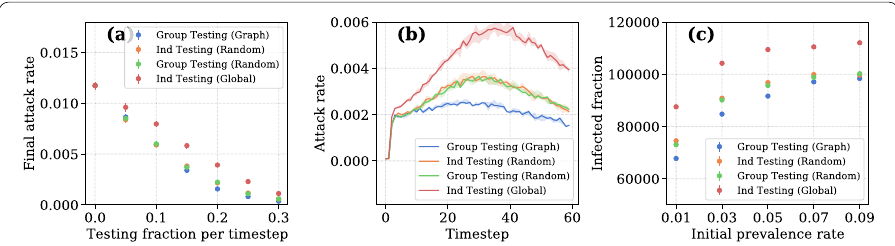
Fig. 4 a Final attack rate (i.e. attack rate at the last timestep) as a function of testing fraction q . δ is fixed at 0.3. b Attack rate over time when q = 0.2 and δ = 0.3 . c Total case counts at varying levels of initial